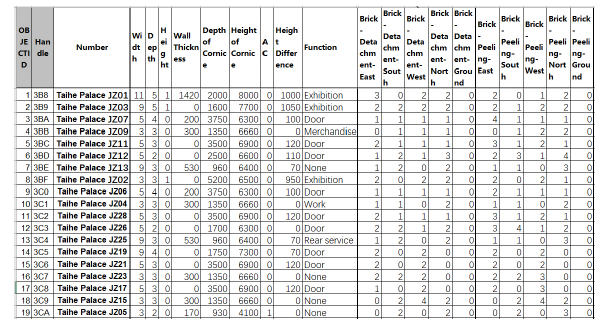
Table 3. ArcGIS database (partial).